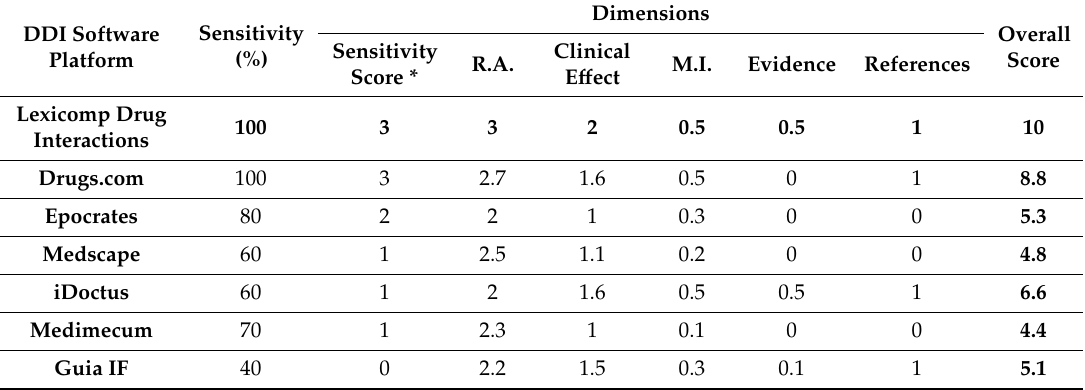
Table 4. Overall and partial performance scores of drug–drug interaction software platforms for the detection and guidance on antimicrobial drug